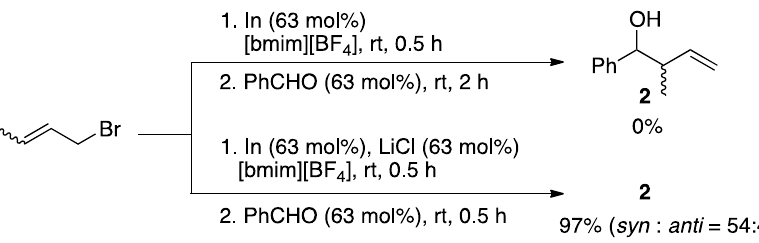
Scheme 1. Effects of LiCl on the crotylation of benzaldehyde.